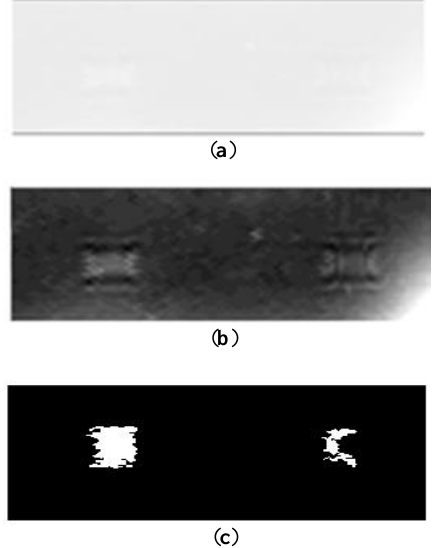
Figure A3. Images of notches 1 and 2 under the 4-mm thick rubber layer obtained at a standoff distance of 0.1 mm: ( a ) original and after ( b ) average filtering and ( c ) thresholding by the developed fuzzy c-mean thresholding algorithm.